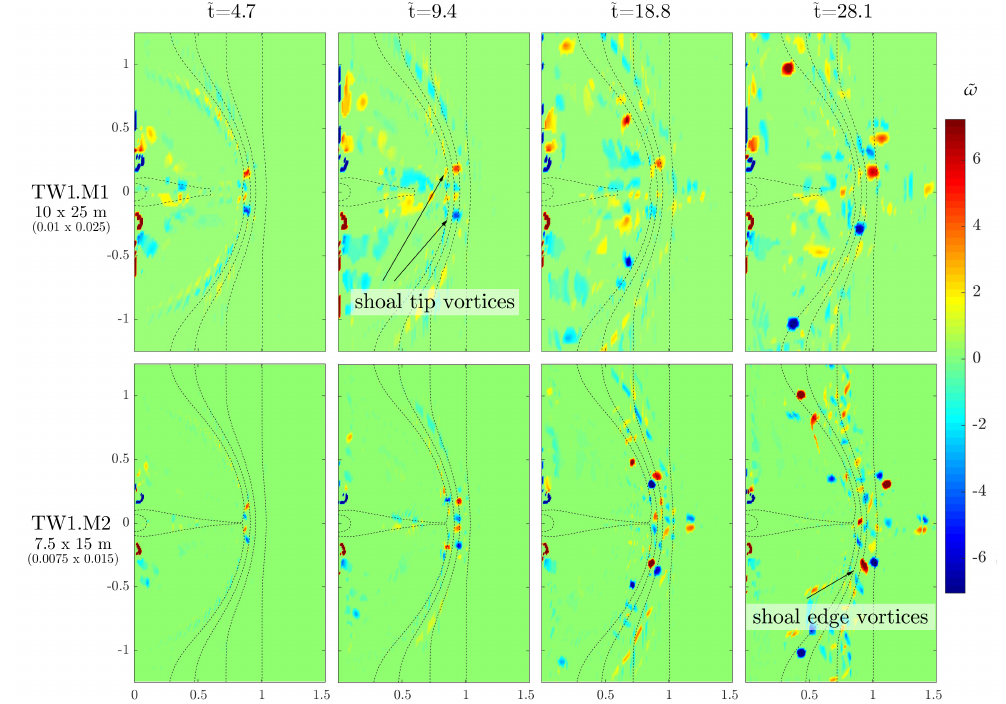
Figure 6. Time evolution of vorticity for test TW1 as a function of the mesh size. Test TW1.M1 has been run with a coarser mesh of size 10 m × 25 m (0.01 × 0.025 in dimensionless units). Test TW1.M2 has been run with a finer mesh of size 7.5 m × 15 m (0.0075 × 0.015 in dimensionless units). Each column represents a single time level (from left to right: ˜ t = 4.7, 9.4, 18.8, and 28.1). Red tones represent clockwise vorticity; blue tones represent anticlockwise vorticity. The dotted lines show the bathymetry contours of the shoal edge and the main channel.